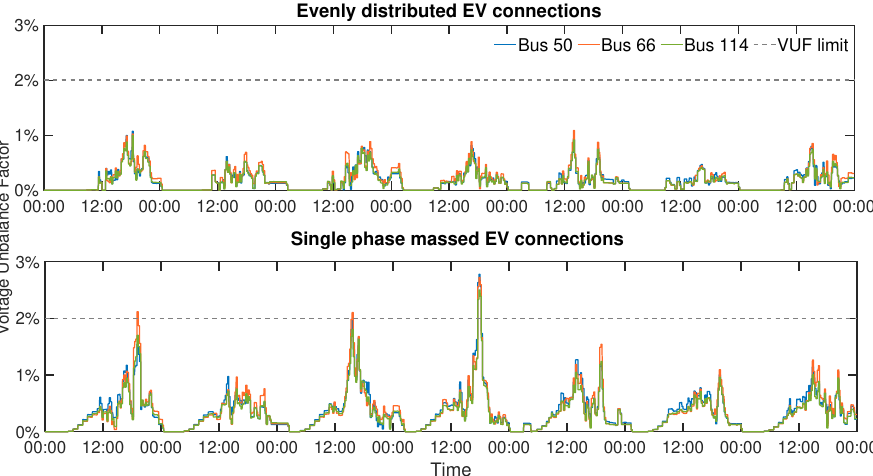
Figure 6. Comparison of voltage unbalance factors at buses 50, 66, and 114 for evenly distributed EV phase connections and for 70% of connections massed on a single phase.